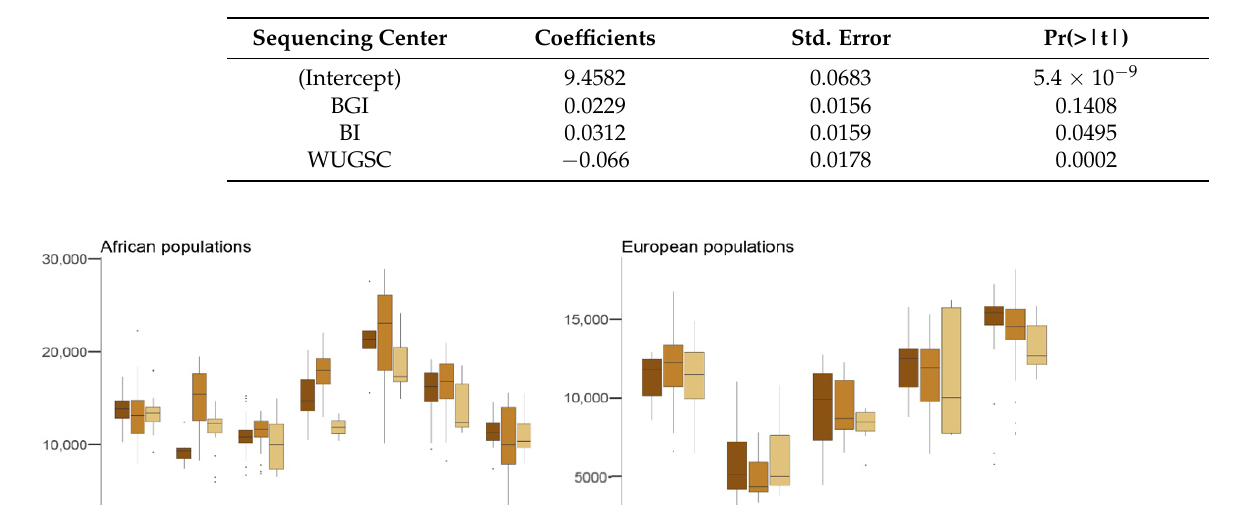
Table 4. Coefficient, standard error, and p value of the coefficient from the hierarchical mixed model using number of singletons as the dependent variable. For this analysis, we only considered sequencing centers that sequenced samples across all populations.